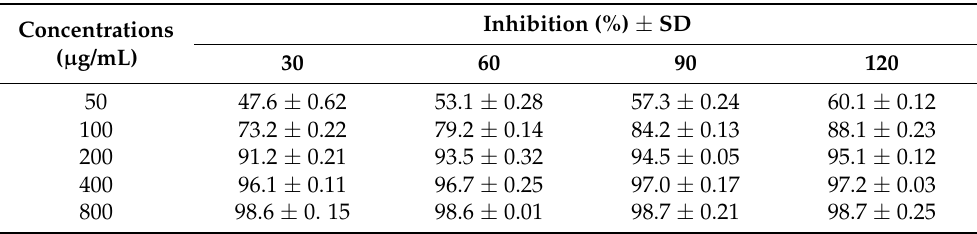
Table 2. Antioxidant activity of clove ( Syzygium aromaticum ) essential oil against 2,2-diphenyl-1- picrylhydrazyl hydroxyl